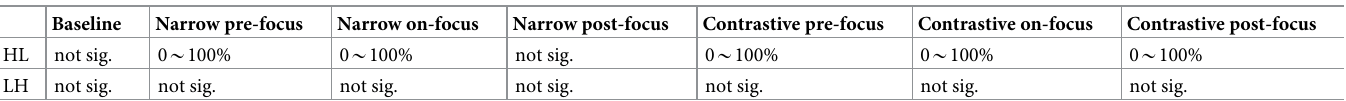
Table 5. Significantly different regions between voiceless and voiced stops in various discourse conditions (Japanese disyllables). Baseline Narrow pre-focus Narrow on-focus Narrow post-focus Contrastive pre-focus Contrastive on-focus Contrastive post-focus HL not sig. 0 * 100% 0 * 100% not sig. 0 * 100% 0 * 100% 0 * 100% LH not sig. not sig. not sig. not sig. not sig. not sig. not sig.